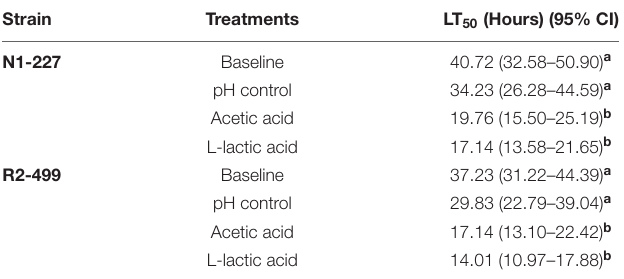
TABLE 3 | Lethal times until 50% population mortality (LT 50 ) for Galleria mellonella larva injected with Listeria monocytogenes strains habituated to various acid